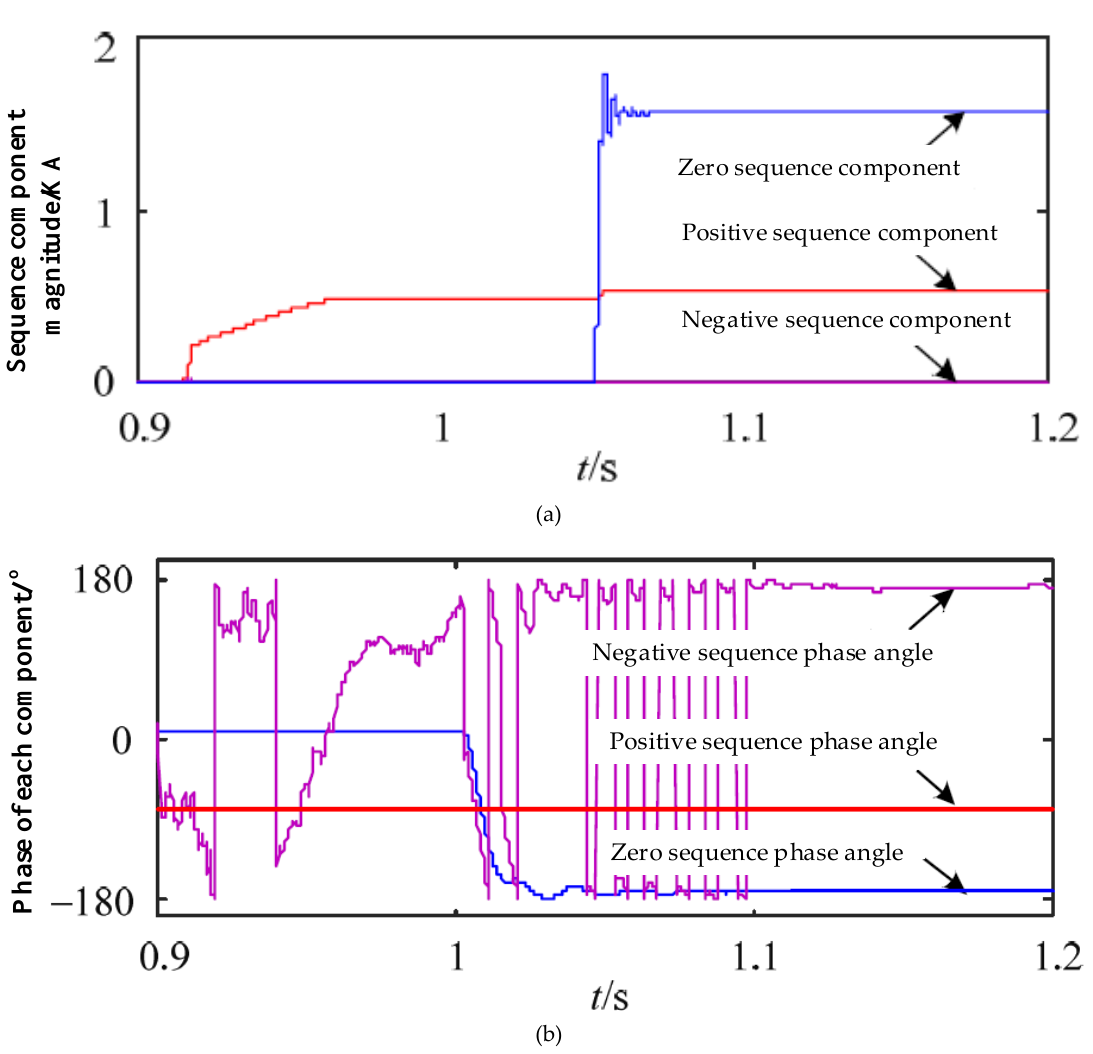
Figure 9. Phase A to ground fault current and phase angle waveform analysis: ( a ) Positive, negative, and zero sequence current components, ( b ) Phase angles.